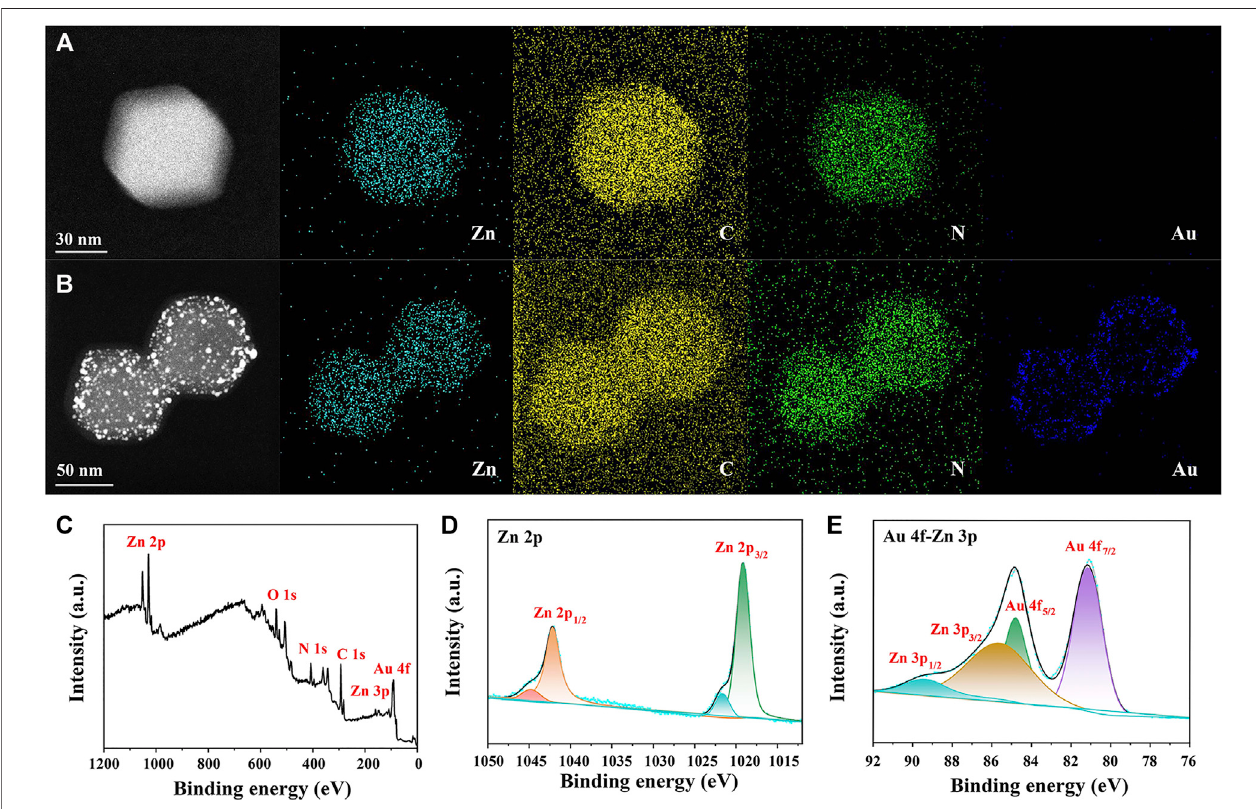
FIGURE 3 | EDS mapping of (A) ZIF-8 and (B) AuNPs/ZIF-8. (C) XPS survey spectrum, high-resolution XPS spectra of (D) Zn 2p and (E) Au 4f-Zn 3p of AuNPs/ ZIF-8.